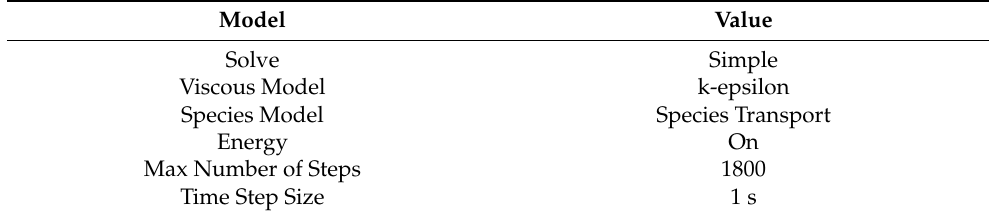
Figure 2. Model and mesh generation.